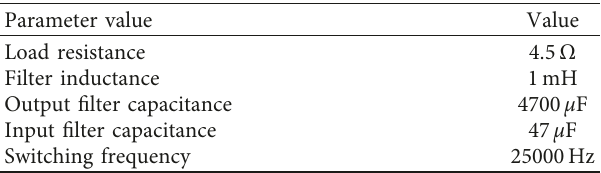
Figure 4: Buck–Boost Simscape model. Table 2: Buck–Boost design